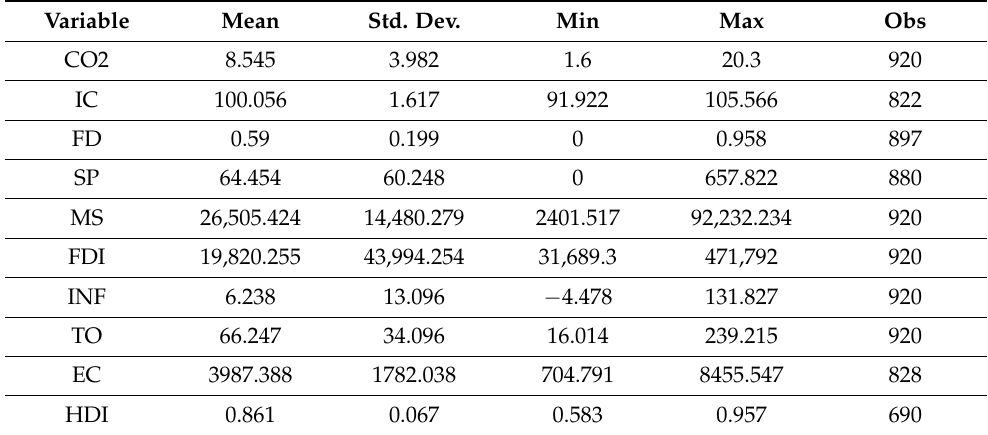
Table 1. Descriptive Statistics.